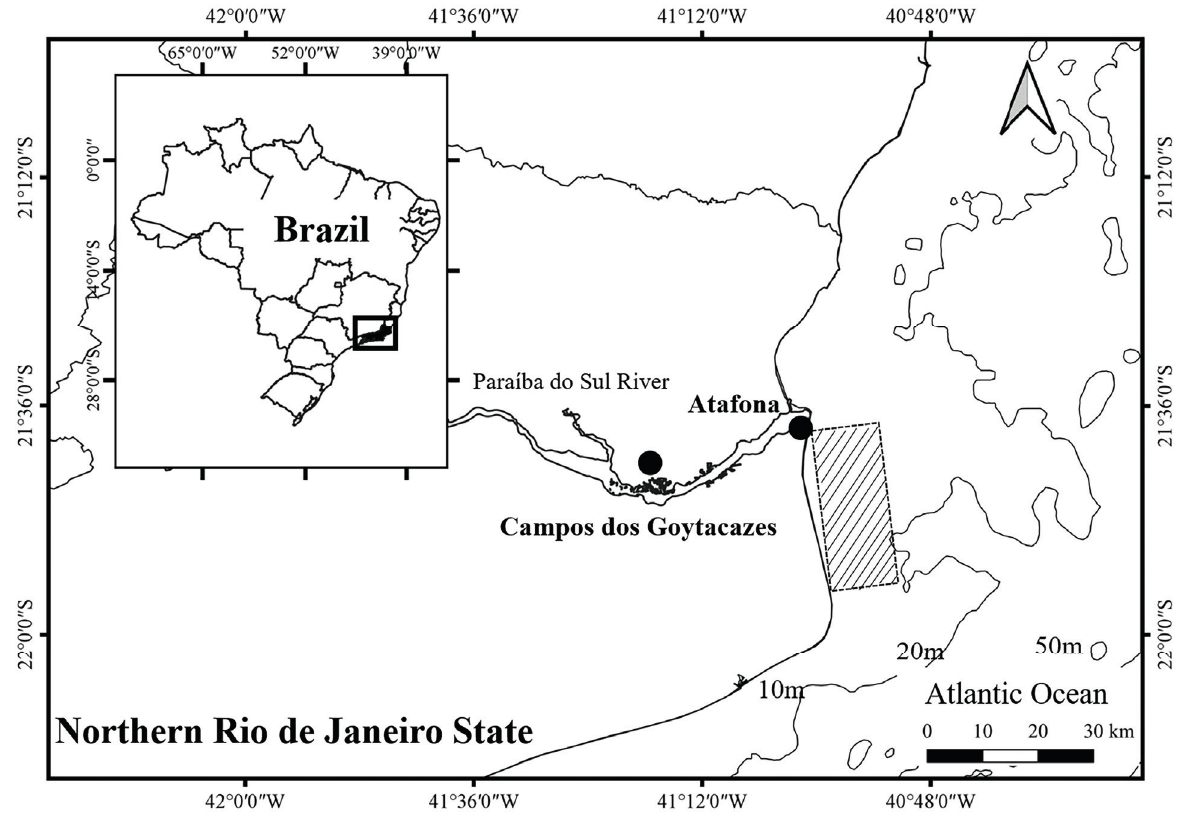
Figure 1. Xiphopenaeus kroyeri fi shing area in northern Rio de Janeiro State, SE Brazil. The dashed area represents the boundaries of the shrimp fi shing